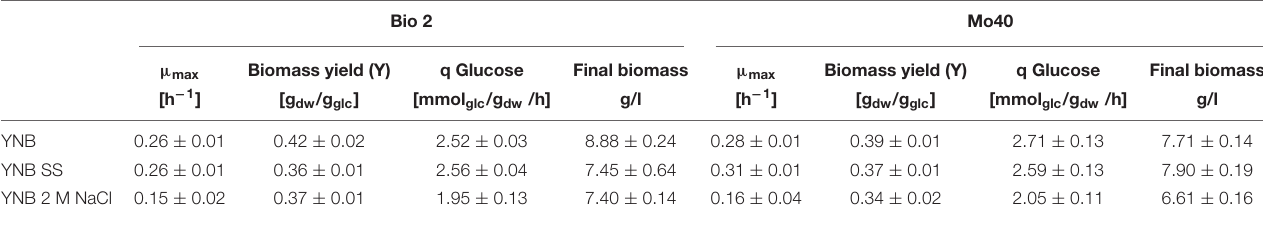
TABLE 1 | Growth parameters of Debaryomyces hansenii Bio2 and Mo40 cultivated in presence of sea salts (SS) and 2 M